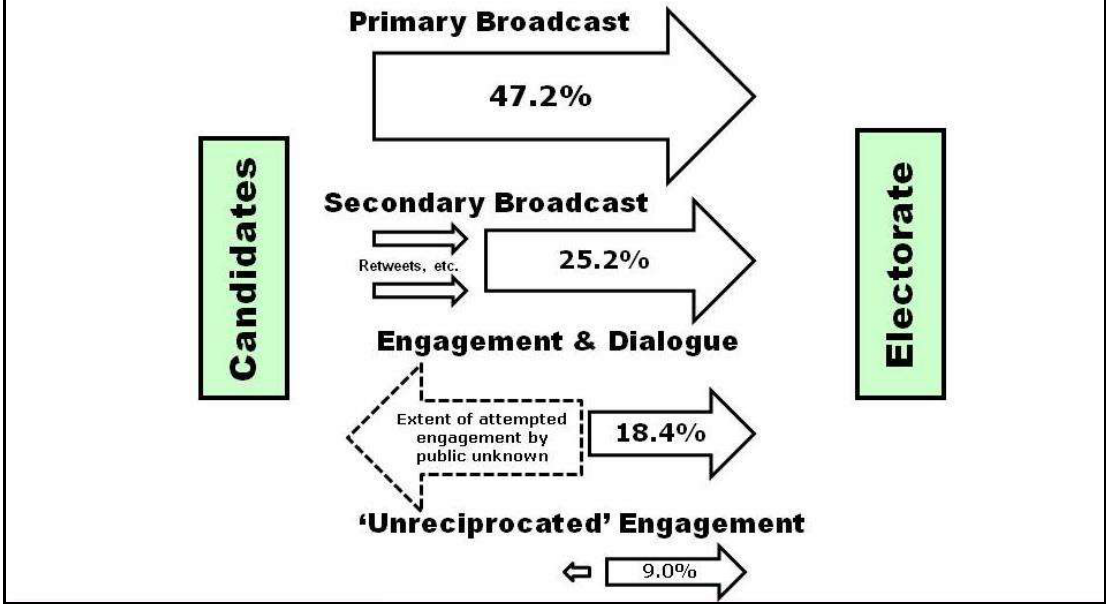
Figure 2: Information Exchange on Candidate Twitter Sites,